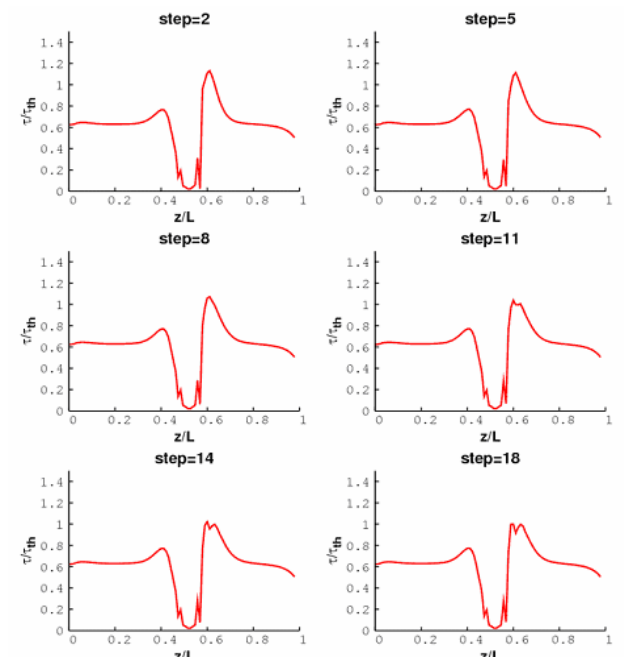
Fig. 5 Plot of the evolution of the WSS distribution for the straight model. Simulation =50 dyne/cm 2 (5.0 Pa). condition: k=1.5 and τ th